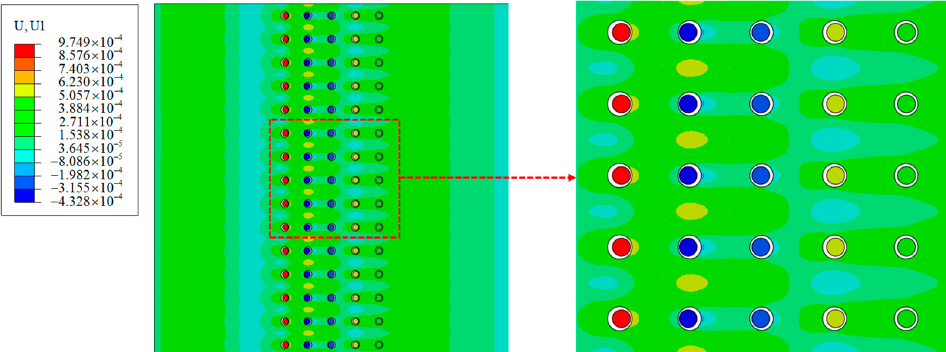
Figure 6. Displacement field in horizontal direction (mm) ( f = 0.6 MHz, t = 0.8 μ s, the insert is the zoom-in view of the region wrapped by the box).